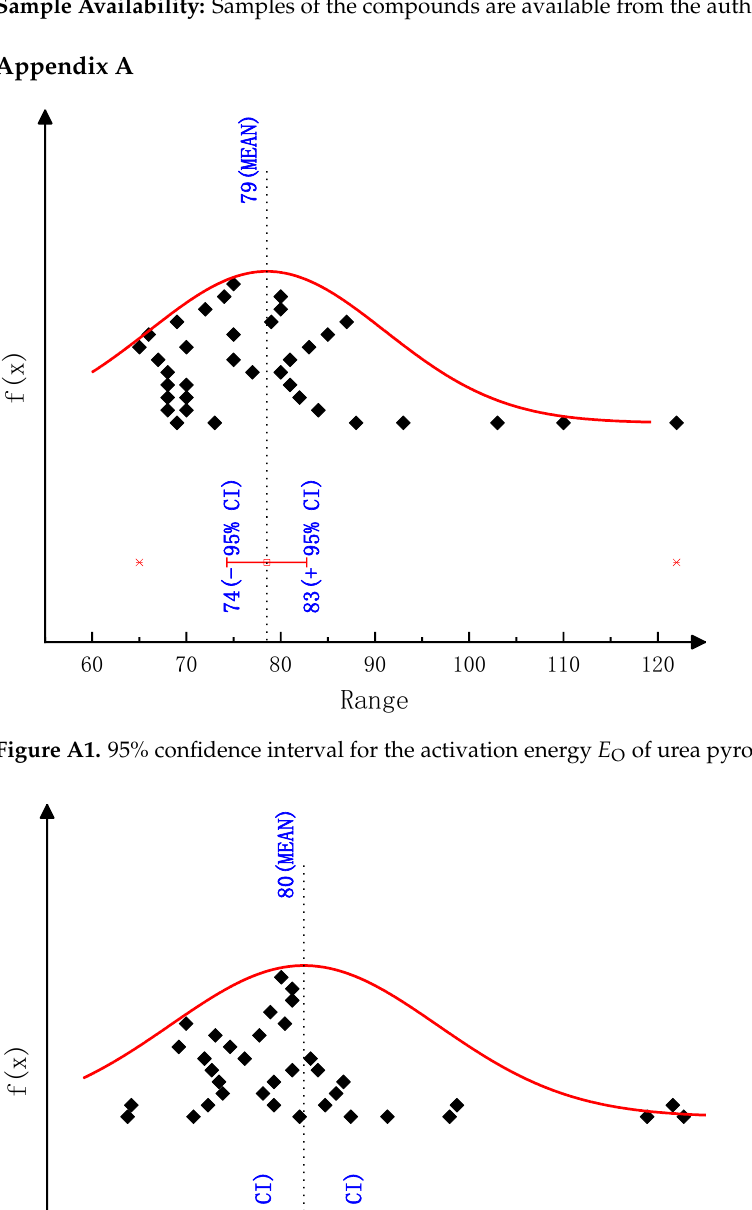
Figure A2. 95% confidence interval for the activation energy E F,2 of urea pyrolysis reaction.